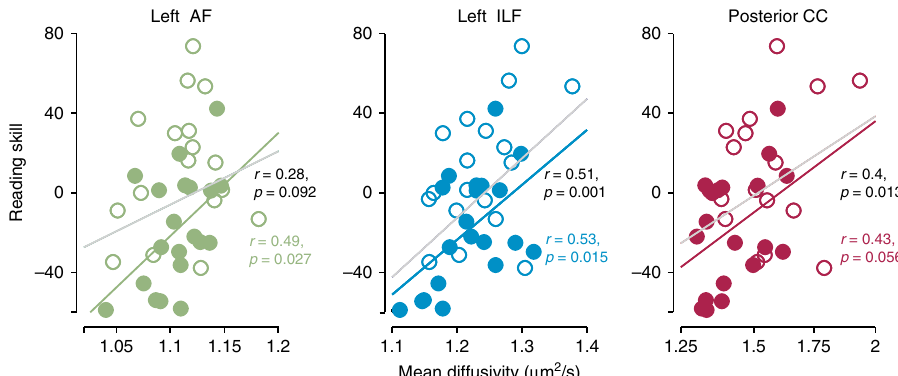
Fig. 1 Pathways connecting the core reading circuitry correlate with pre-intervention Reading Skill. Tract average mean diffusivity (MD) is plotted as a function of pre-intervention (Session 1) reading skill. Best- fi t lines plotted in gray give estimates for the full dataset, while colored lines show fi ts for the intervention subjects, alone. Correlations for the intervention subjects are given in colored text below the value estimated for the full dataset